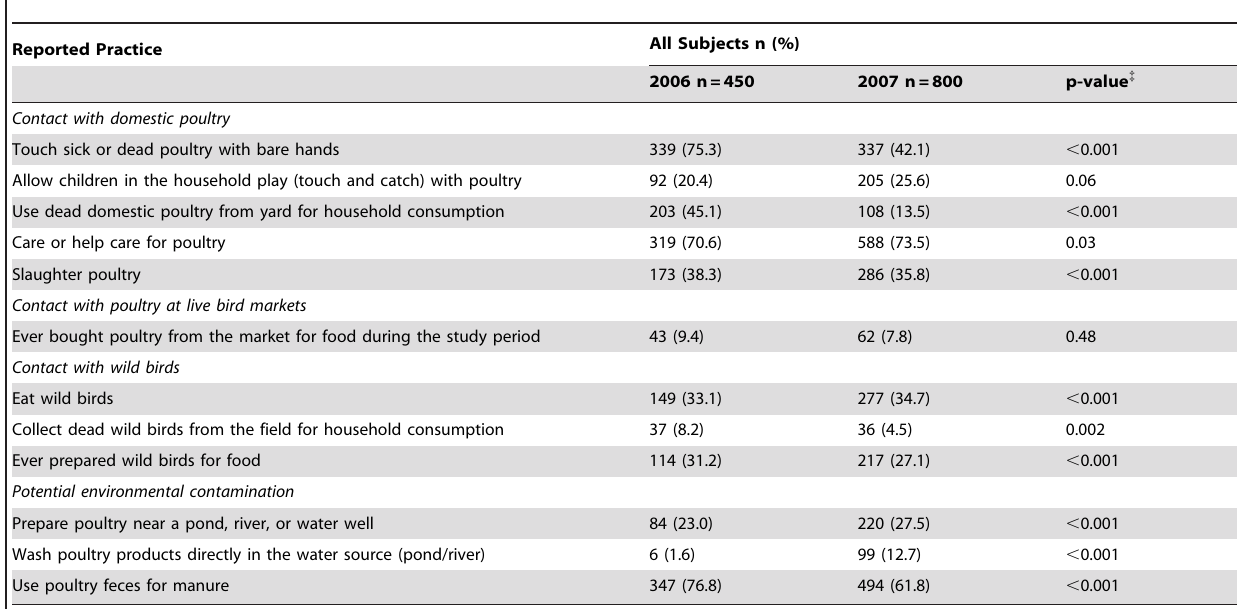
Table 3. Changes in poultry contact in Kampong Cham and Prey Veng provinces, Cambodia from January 2006 to December